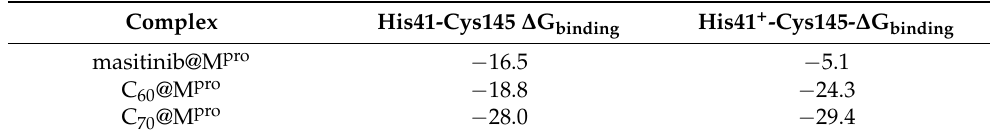
Table 4. Comparison of the binding energy of masitinib, C 60 , and C 70 with M pro in the two protomeric states, namely, His41-Cys145 and His41 + -Cys145 − . All energies are reported in kcal mol − 1